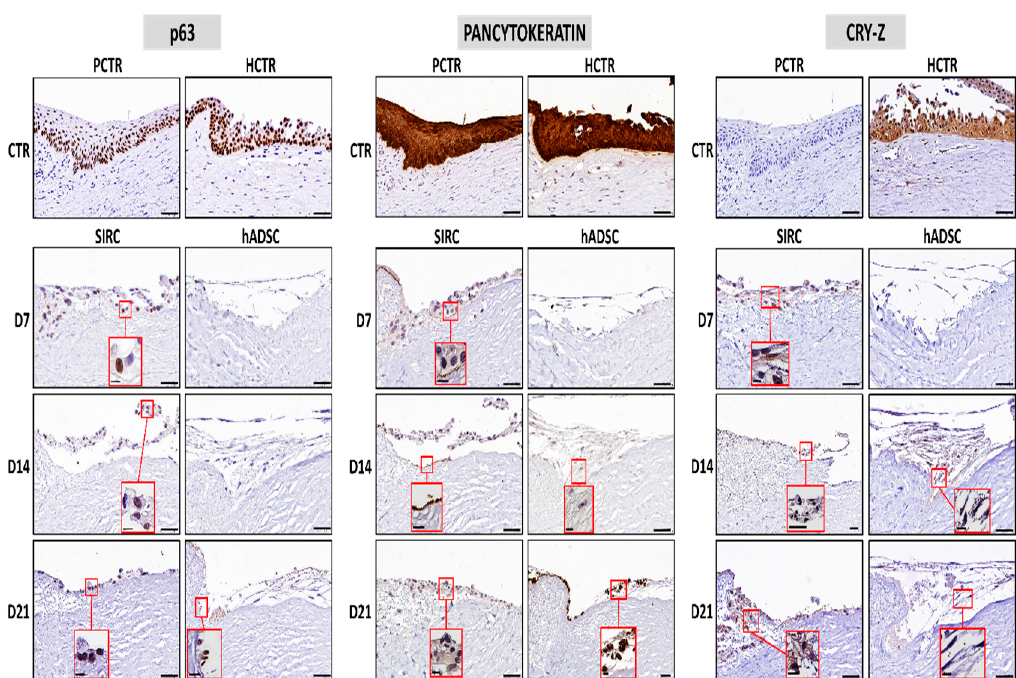
Figure 6. Immunohistochemical analysis of the corneal epithelial cell markers p63, pancytokeratin, and crystallin Z (CRY-Z) in RLs recellularized with SIRC cells and hADSCs at days 7 (D7), 14 (D14), and 21 (D21) of follow-up, porcine native limbus (PCTR), and human native limbus (HCTR). Insets correspond to higher-magnification images of cells showing the expression of each analyzed marker in the RL tissues. Scale bars: 50 μ m for large images and 10 μ m for the insets.